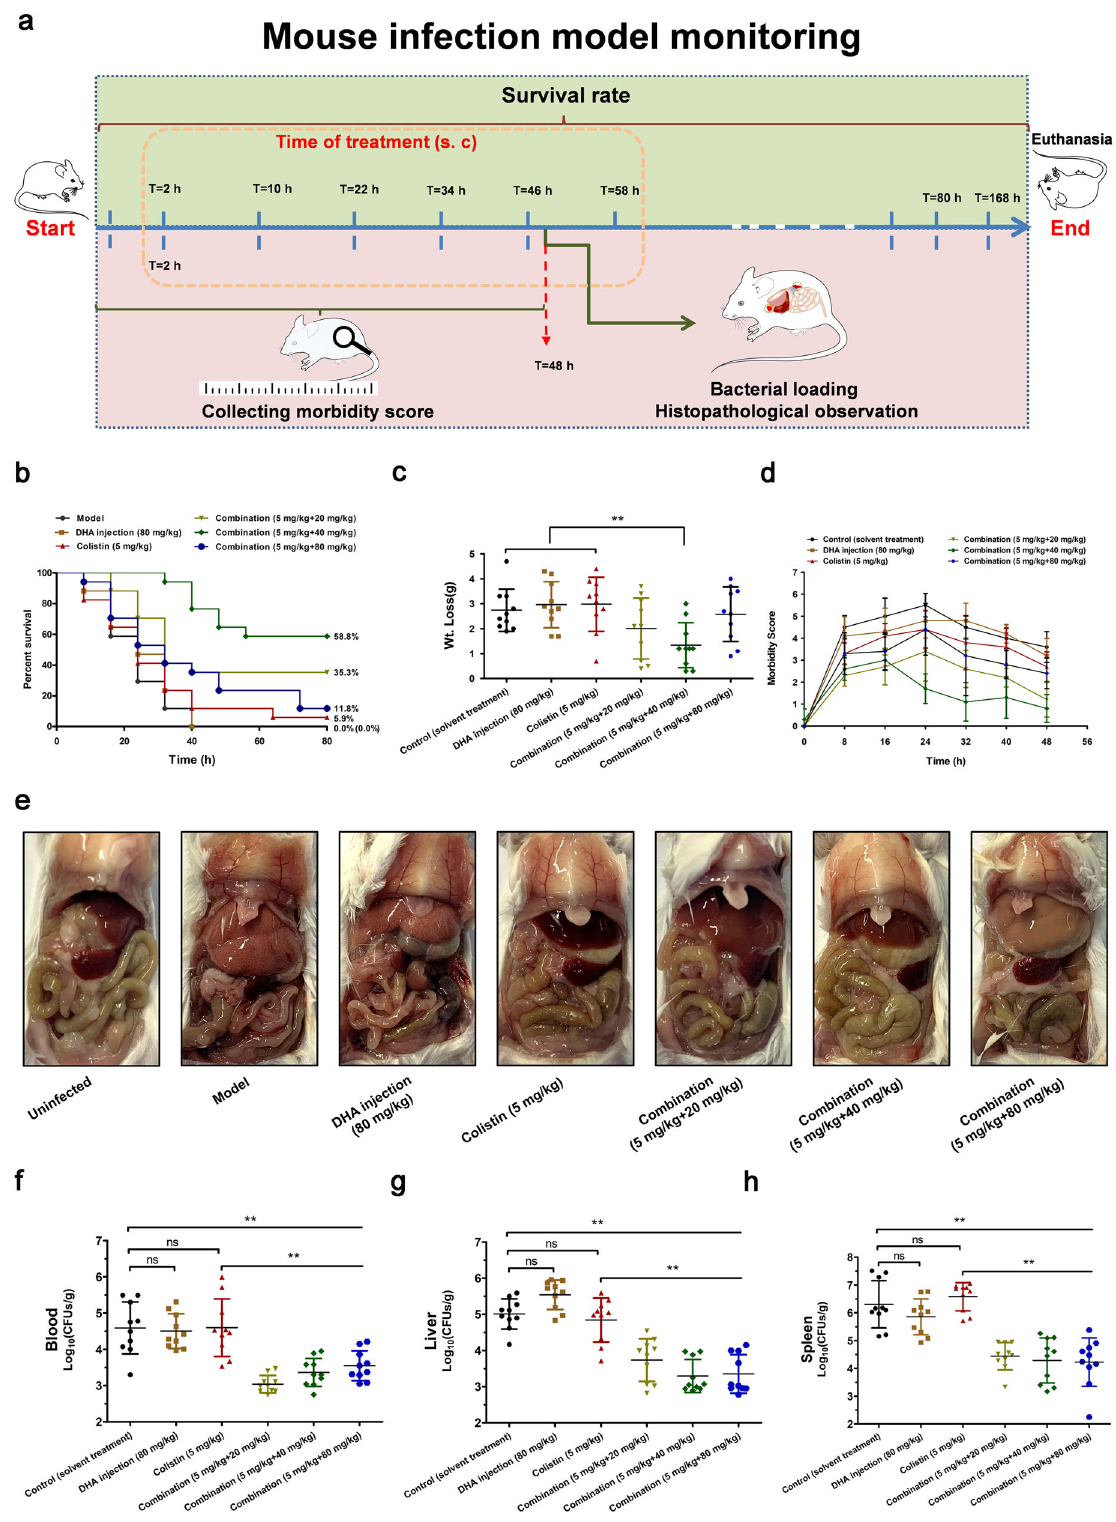
Fig. 9 Effects of DHA injection and colistin combination therapy against E. coli W3110 (pUC19- mcr-1 ) in vivo. a Mouse infection model monitoring including survival rate, time of treatment, Wt. Loss (weight loss), morbidity score, bacterial loading and histopathological observation. b Survival plot of mice inoculated via intraperitoneal injection with E. coli W3110 (pUC19- mcr-1 ) (17 mice per group). c – h The Wt. Loss ( c ), morbidity score ( d ), histopathological observation ( e ) and the bacterial burden in the blood ( f ), liver ( g ) and spleen ( h ) were calculated ( n = 10). ** P < 0.01. ns indicates no signi fi